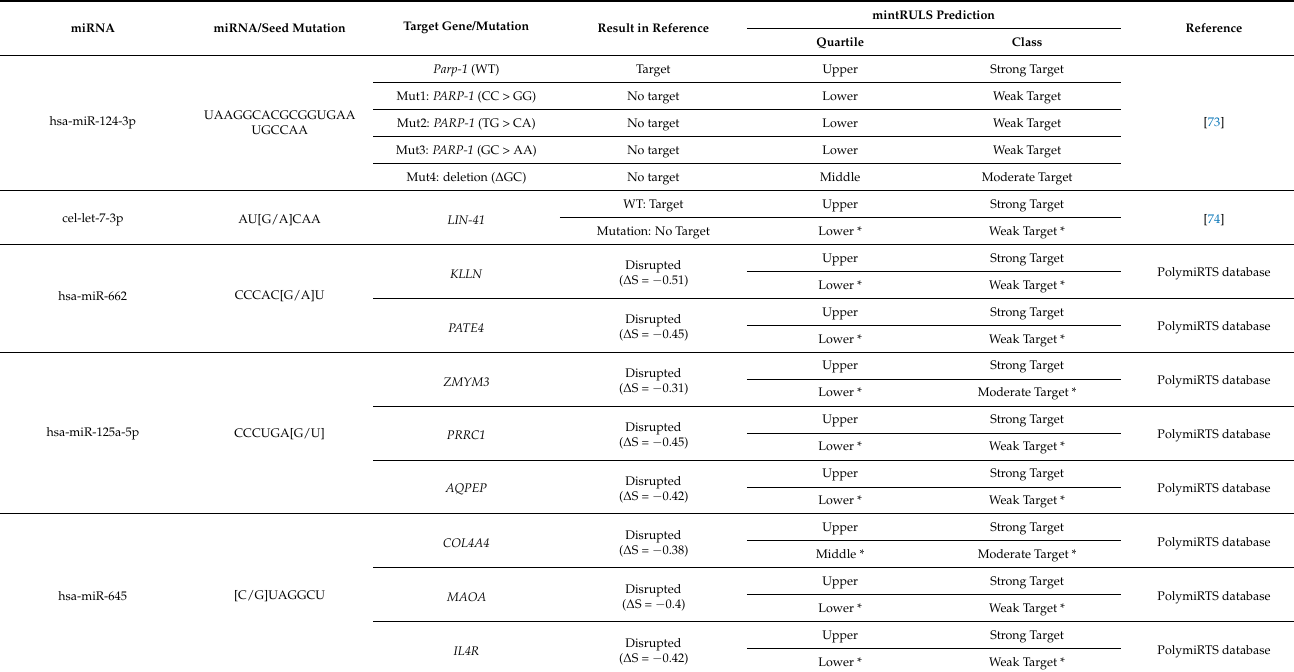
Table 3. Validation of mintRULS predictions in case of mutations in the seed region of miRNAs or in the target gene itself. Upper quartile (>75th percentile), Moderate Target: Middle quartile (in between 25th and 75th percentile), and Weak Target: Lower quartile (<25th